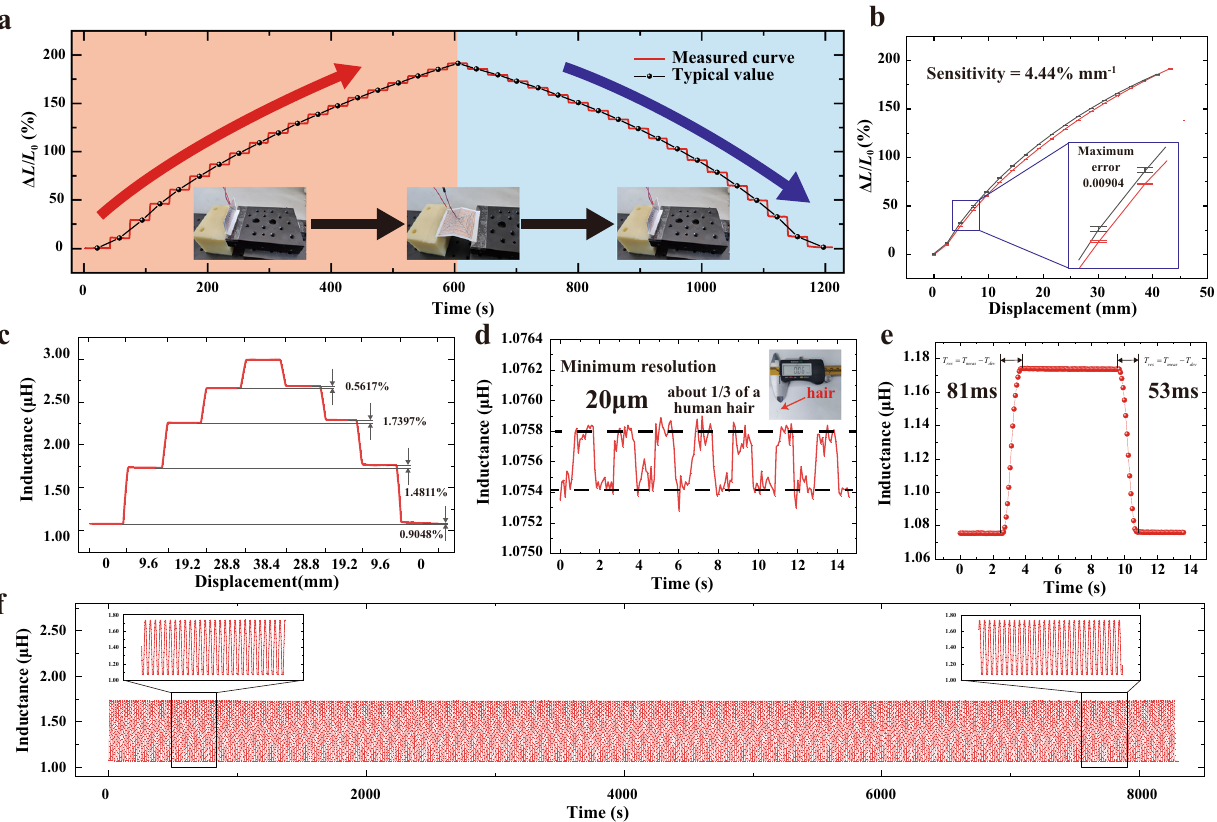
Fig. 6 Performance testing of PSIFS. a Measurement curve in full range. b Sensitivity curve and error PSIFS. The error bar shows the standard deviation. c Inductance variation curves of PSIFS at the same measurement position in lifting and returning. d Cycling test of PSIFS in minimum resolution displacement (20 μ m). e Measurement curve of the response time of PSIFS. f Long-term stability test curve of